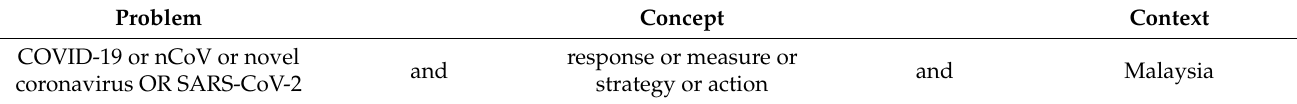
Table A1. Search terms used in this